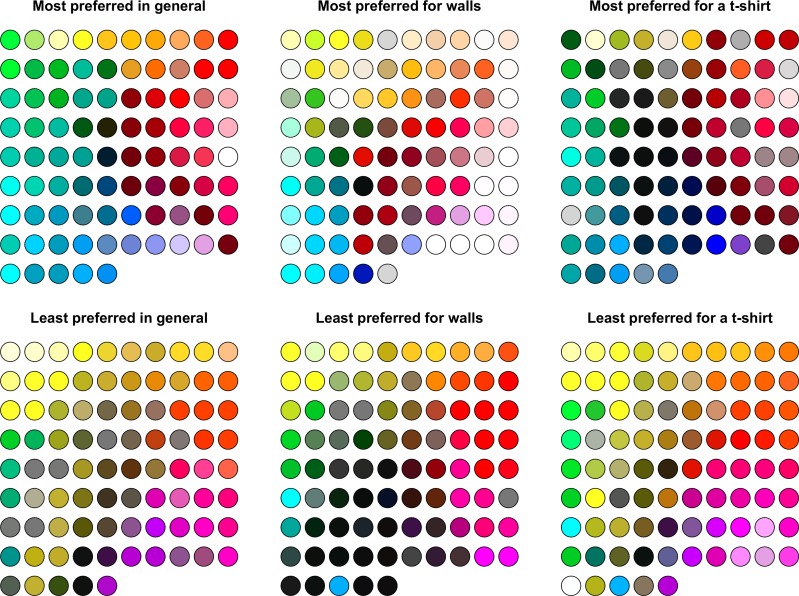
Most preferred and least preferred colour choices in three context conditions.Each colour patch represents a colour choice of one participant. Their positions are defined by 1) hue so that neighbouring hues on the colour circle (e.g. orange and yellow) appear next to each other in the graph, and 2) lightness so that darker colours appear closer to the centre as compared to lighter colours. The colours were derived from the CIE LCh values.